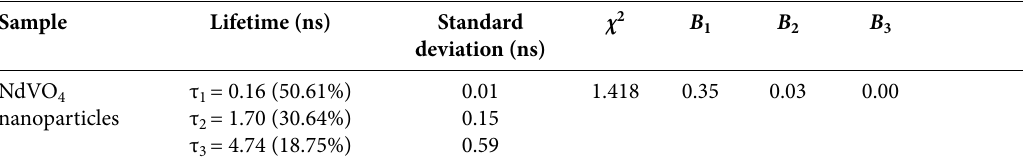
Table 4. Fitting parameters of the photoluminescence decay curves of the NdVO 4 nanoneedles ( λ ex = 371 nm, λ em = 524 nm).